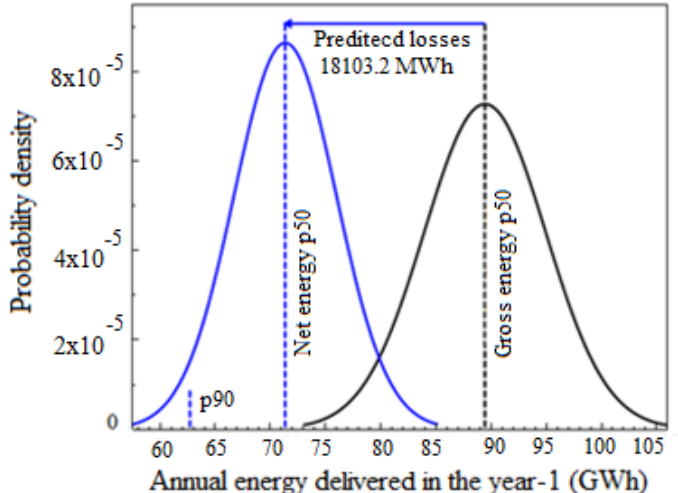
Figure 17. System’s predicted losses considering wake losses (layout 2). Wake losses in layout 2 are significant when the wind direction coincides with the direction comprising the largest number of turbines, as presented in Figure 18.